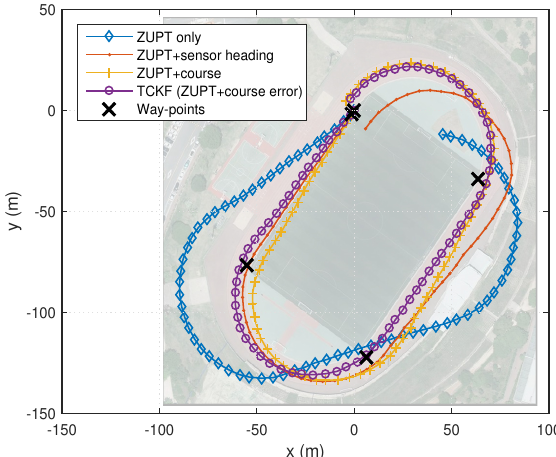
Figure 8. PDR results for the navigation systems on the right foot.